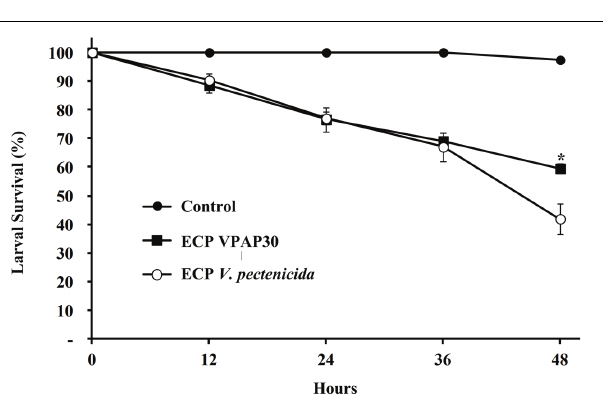
FIGURE 6 | Survival of 10-day-old scallop larvae not challenged (control) and challenged with extracellular products of V . tubiashii VPAP30 and V . pectenicida A365. Values are a mean ( ± SD) of three replicates. Asterisks indicate significant differences.